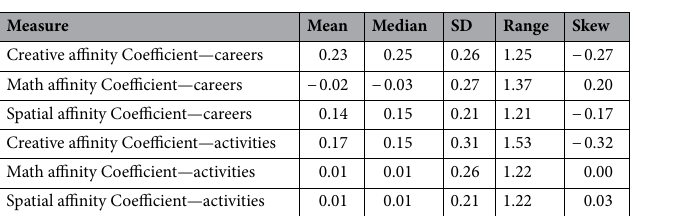
Table 3. Shows descriptive statistics for all affinity